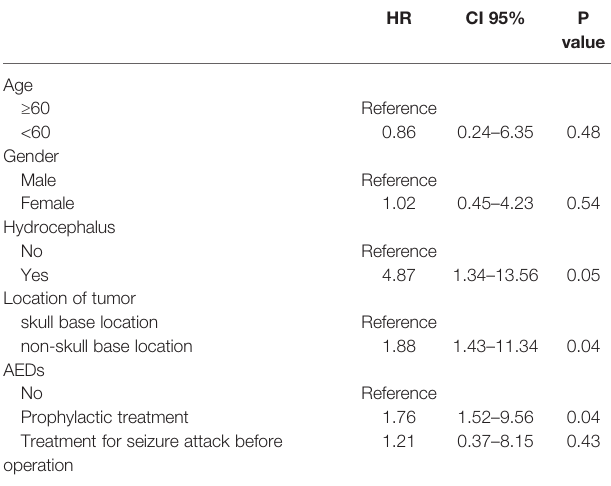
TABLE 2 | Multivariate logistic regression analysis of study population.